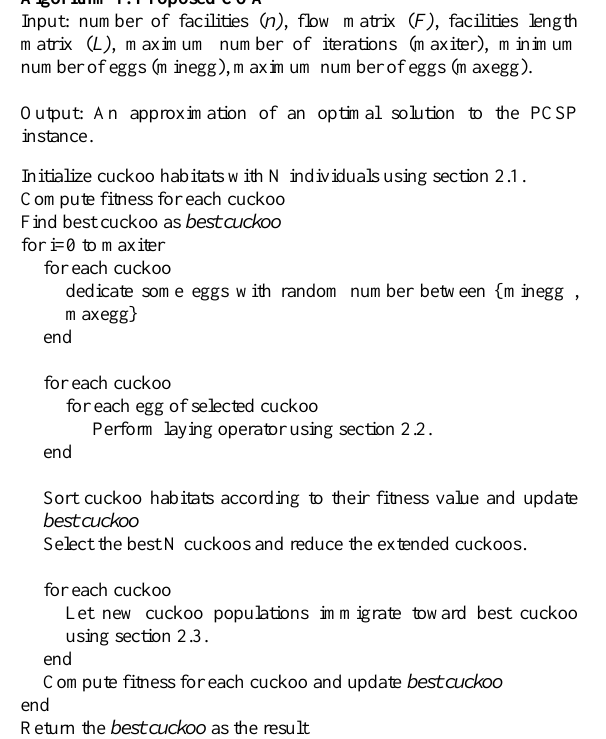
Figure 9. New position of migrant